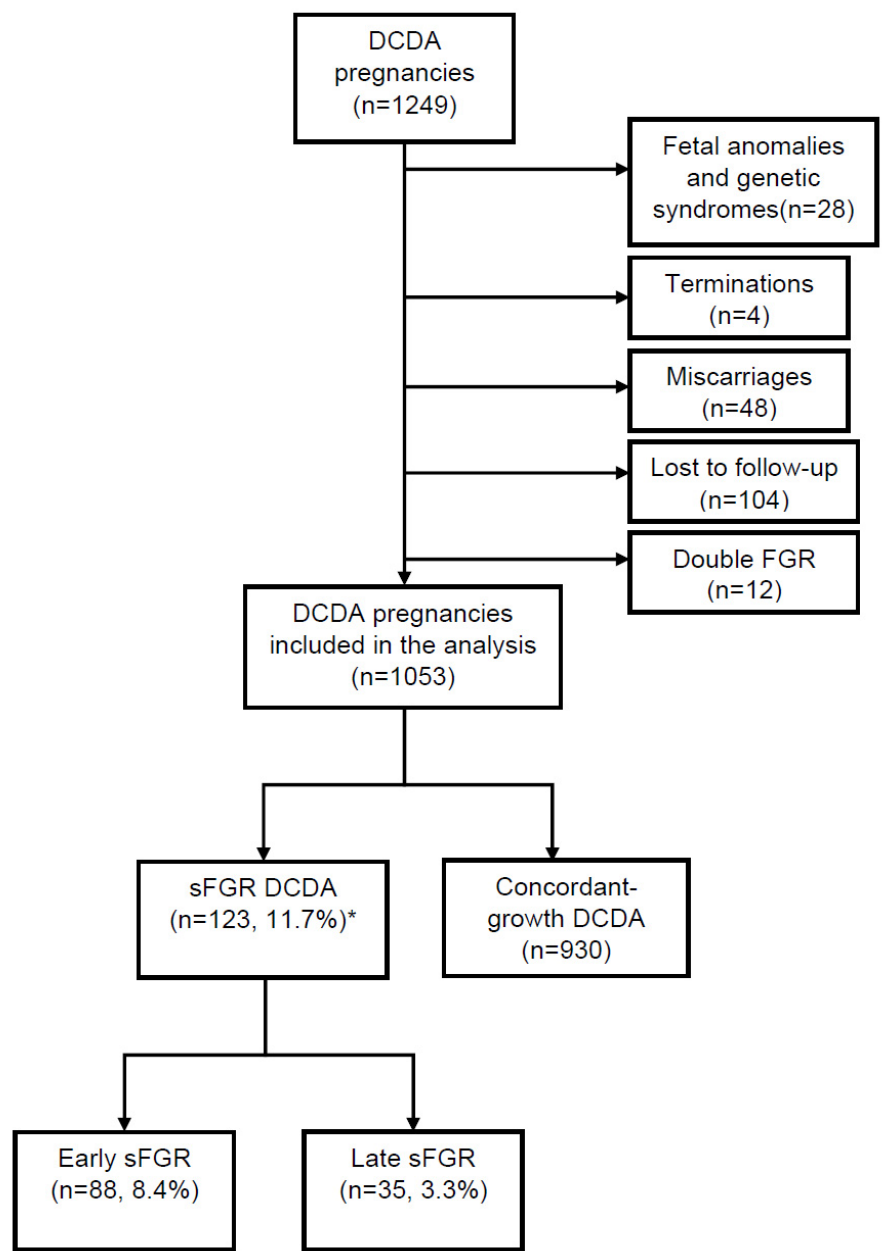
Figure 1. Flow diagram representing the whole study population of dichorionic diamniotic twin pregnancies ( n = 1249). DCDA: dichorionic diamniotic, sFGR: selective fetal growth restriction. * Incidence of sFGR classified according to Delphi diagnostic criteria.